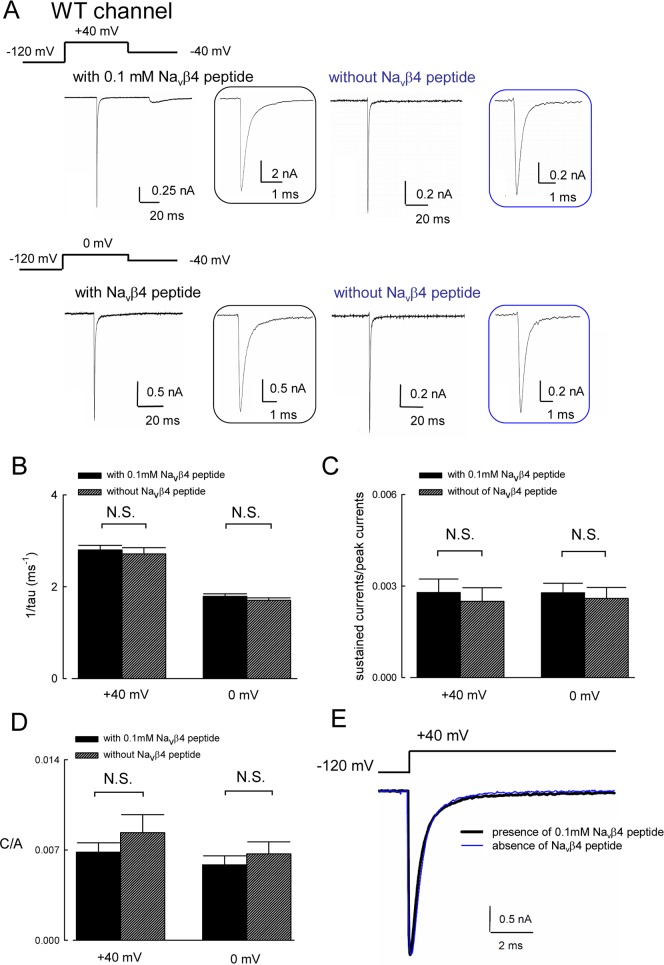
Resurgent and transient Na+ currents of WT Nav1.7 channel in the presence and absence of the Navβ4 peptide.(A) The cells were held at –120 mV, and the resurgent Na+ currents were evoked by a voltage steps to –40 mV after a prepulse to either +40 mV or 0 mV for 30 ms in the presence or absence of 0.1 mM Navβ4 peptide. Inset figures: the transient currents during the prepulses are magnified in the time axis. (B) The decay phase of the transient currents from the 95% of the peak to the steady-state current was fitted by a standard exponential function: f(x) = A×exp(–t/τ)+ C. Note that the time constants of the decay phase of transient Na+ currents at +40 mV prepulse are shorter than that at 0 mV, but both remain the same in the presence and absence of 0.1 mM Navβ4 peptide (n = 15; N.S., no statistically significant difference). (C) Cumulative results were obtained from experiments with similar protocols described in part A but with longer prepulses to either +40 or 0 mV for ~100 ms in the WT channel. The sustained currents are defined as the average currents from 75 to 80 ms after peak transient current (and normalized to the peak transient current in the same sweep). At either +40 or 0 mV depolarization, there is no significant difference in the normalized sustained currents in the presence and absence of 0.1 mM Navβ4 peptide (n = 15; N.S., no statistically significant difference). (D) Cumulative results of C/A values from part B (C is divided by A from the same fit) are also compared to further substantiate the unaltered sustained currents by the Navb4 peptide either at +40 or 0 mV (n = 15 for each condition; N.S., no statistically significant difference). (E) The transient Na+ currents are adjusted to the same peak current amplitude and then average currents are obtained in the presence and absence of 0.1 mM Navβ4 peptide (n = 15 for each condition). Note that the two average currents are essentially superimposable. Individual data is shown in the file of S1 Data.